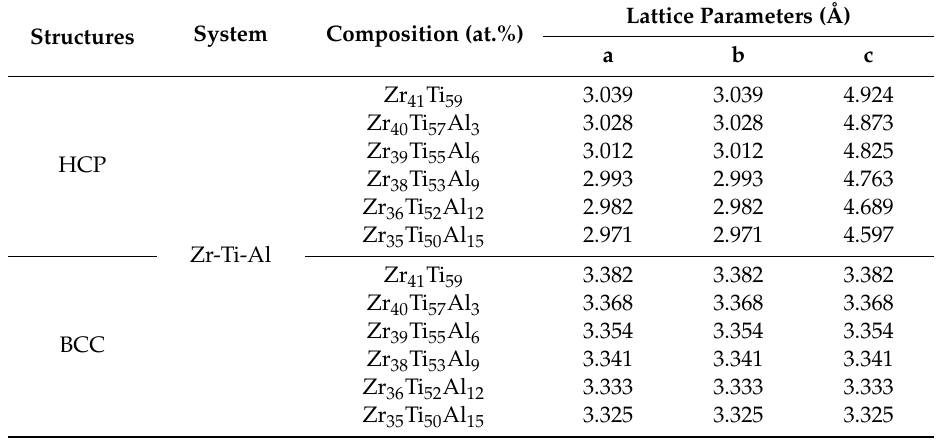
Table 5. E ff ect of Al atomic fraction on single crystal cell parameters of HCP structure and BCC structure Zr-Ti-Al alloy